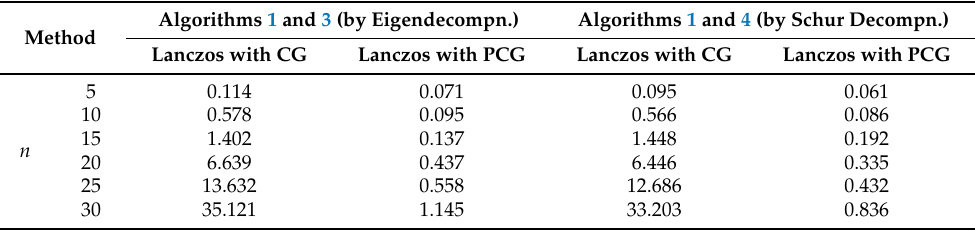
Table 4. Running time (seconds) of the Lanczos method using the CG/PCG method in the case of the 5-th max. singular value of almost symmetric matrix T with a = c = 1 and b = 0.01 in (9) for the shift